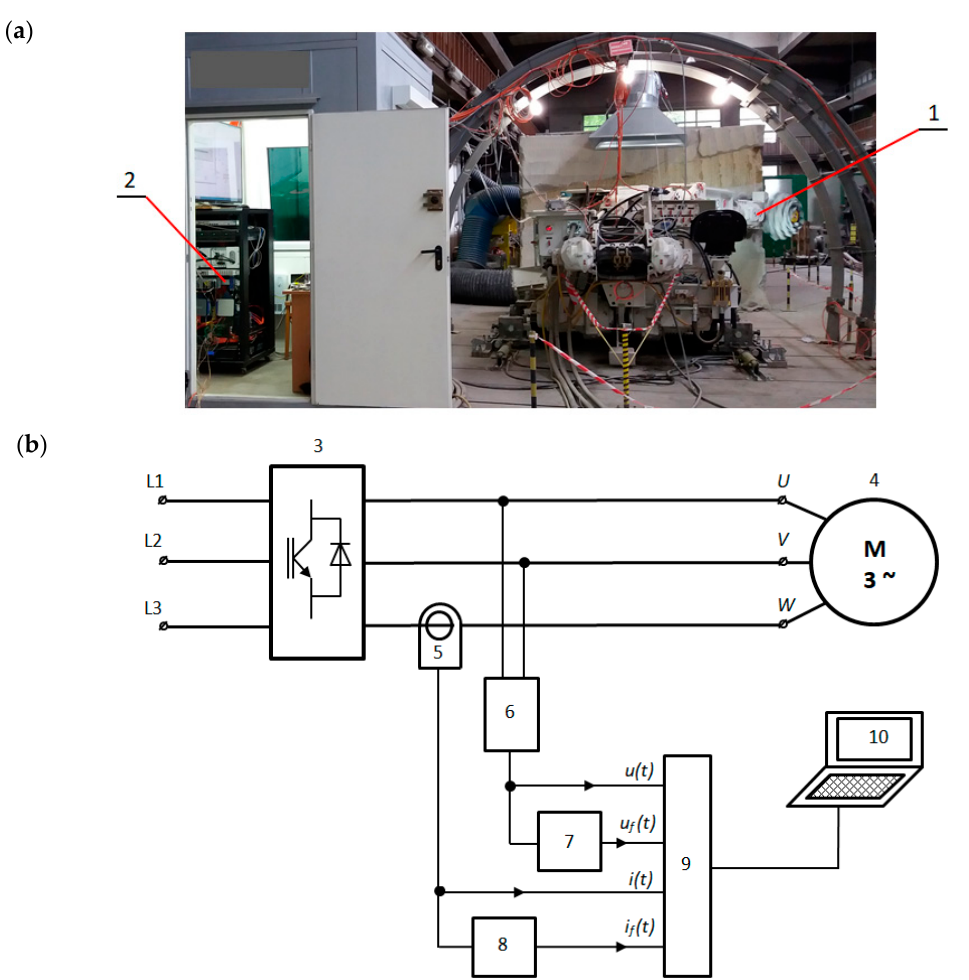
Figure 6. Stand for testing the converter drive system of the roadheader’s cutterhead; ( a ) view of the stand, ( b ) block diagram of the measuring system used during the measurements aimed at evaluating the analog filters’ performance; 1—roadheader, 2—stand for control and measurements of electrical and mechanical parameters of a roadheader with an analog filter system.